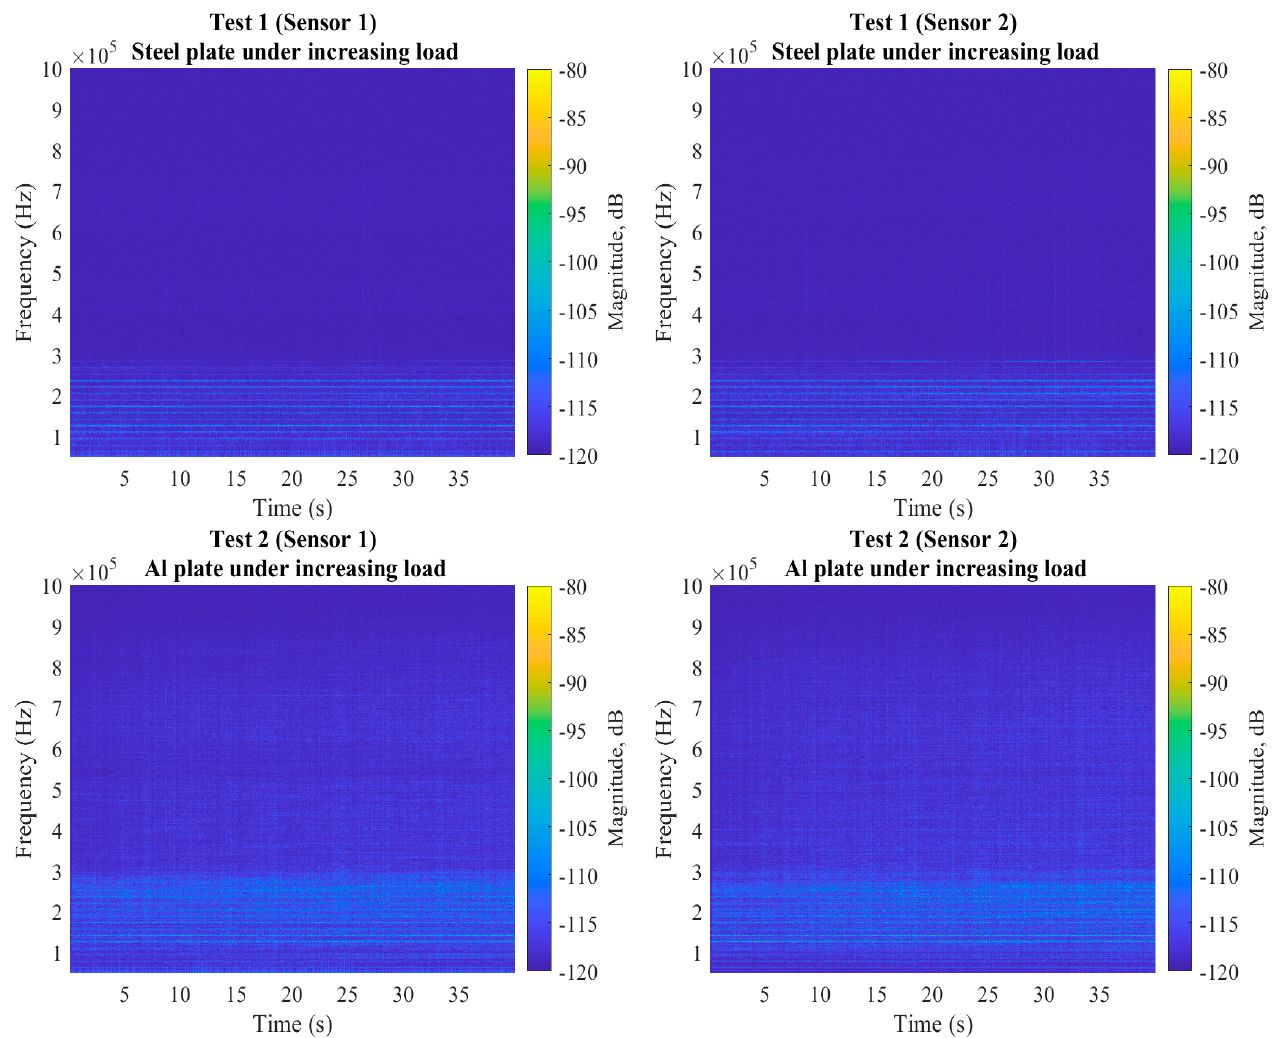
Figure 7. STFTs for scratch tests of tool steel indenter on steel sheet ( top ) and tool steel on aluminium sheet ( bottom ) under increasing load.